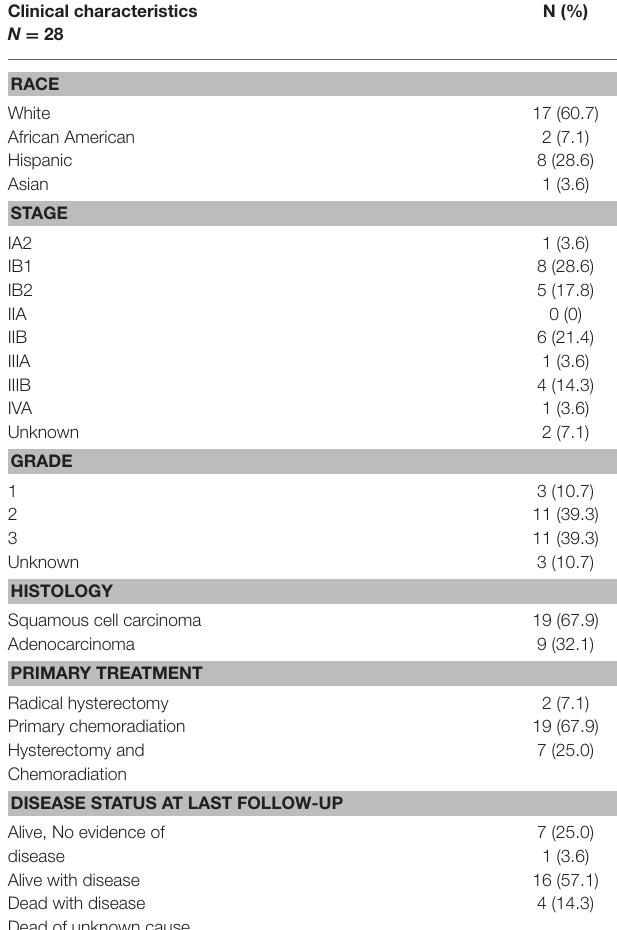
TABLE 1 | Clinical characteristics of patients. Clinical characteristics N =